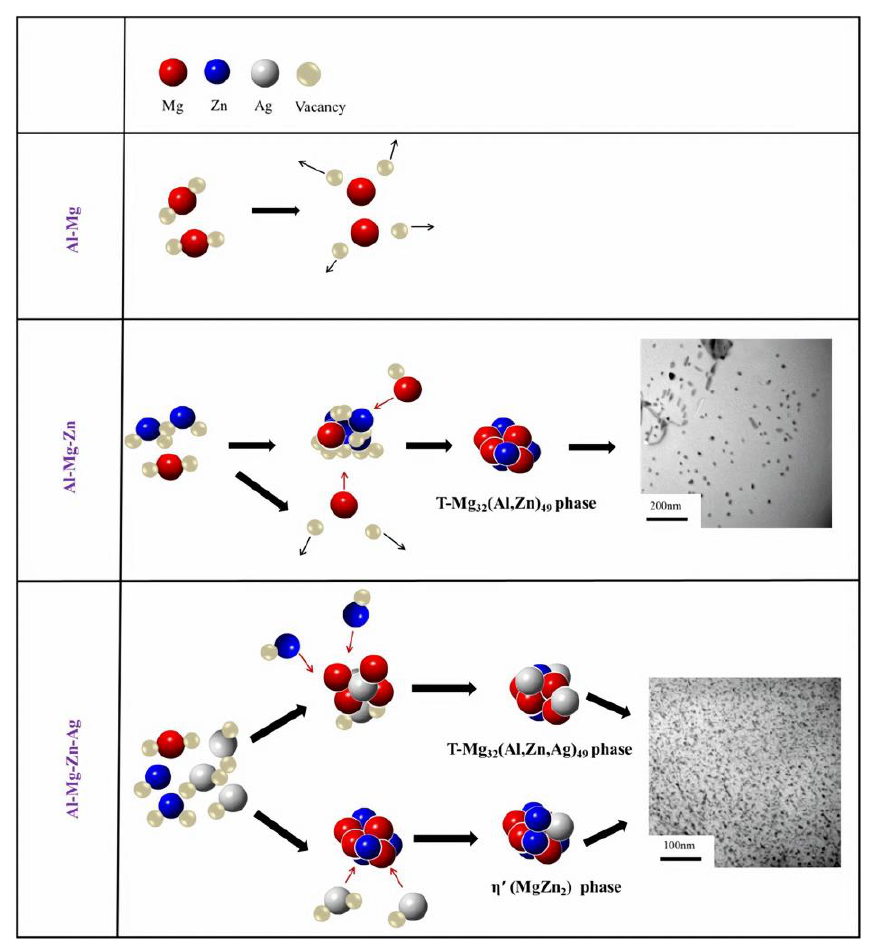
Figure 5. Schematic illustration showing the atomic aggregation [32].